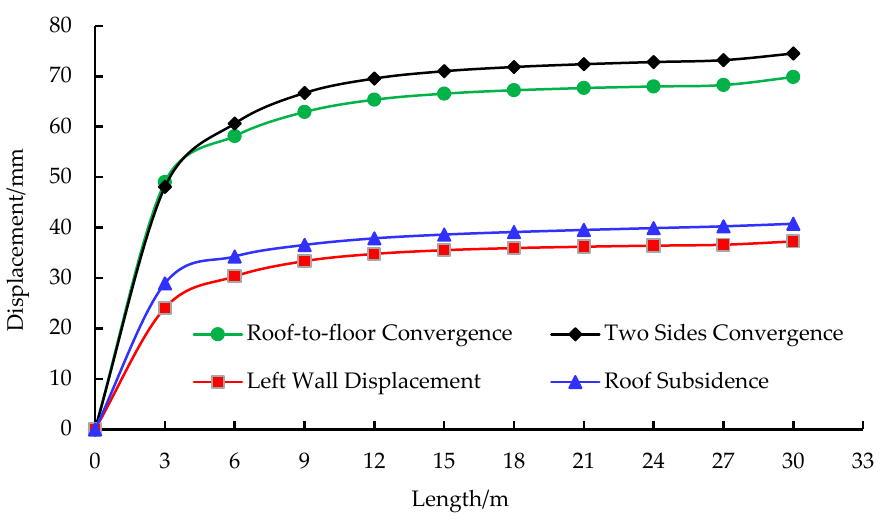
Figure 8. Deformation of roadway surrounding rock with excavation length without support.